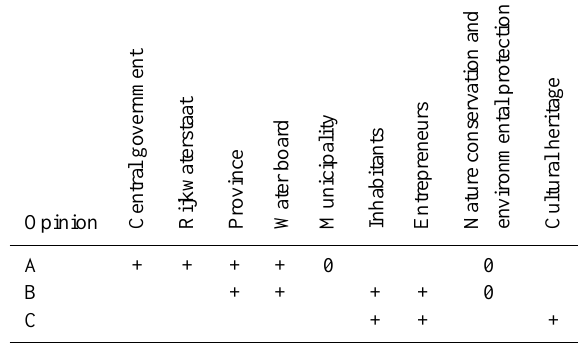
Robust multifunctional approach